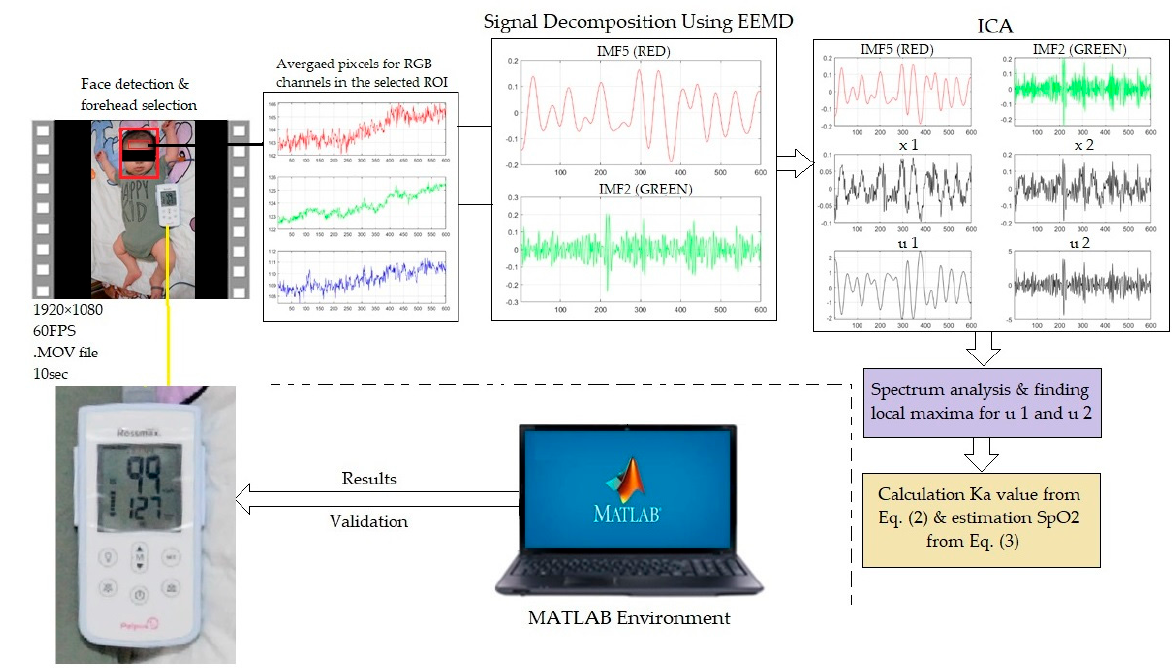
Figure 3. Overall system design of the non-contact SpO2 prediction.